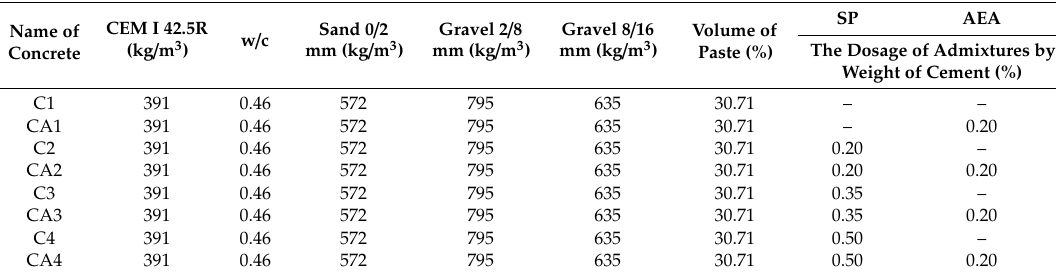
Table 3. The components of the